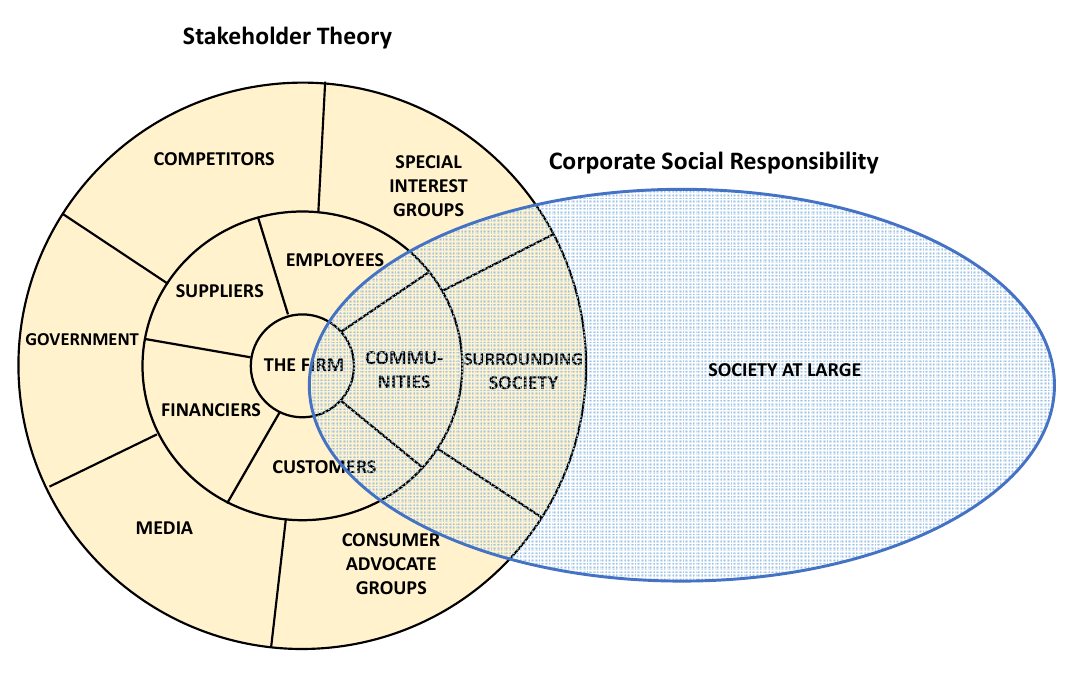
Figure 1: The relation between Stakeholder Theory and